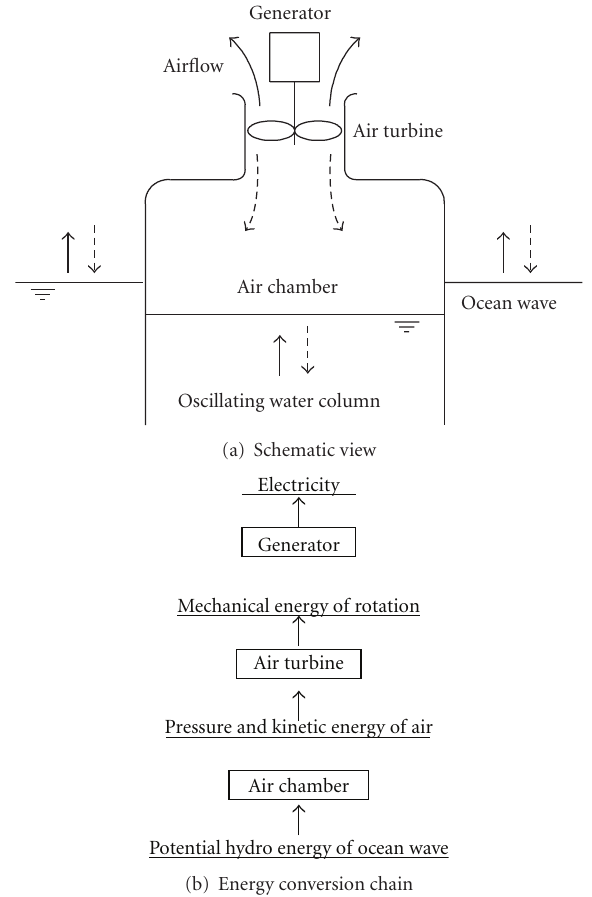
Figure 1: Outline of oscillating water column (OWC) device.